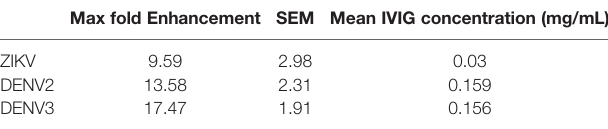
TABLE 2 | Analysis of antibody dependent enhancement of ZIKV-IG against ZIKV and DENV2 and 3. Max fold Enhancement SEM Mean IVIG concentration (mg/mL)